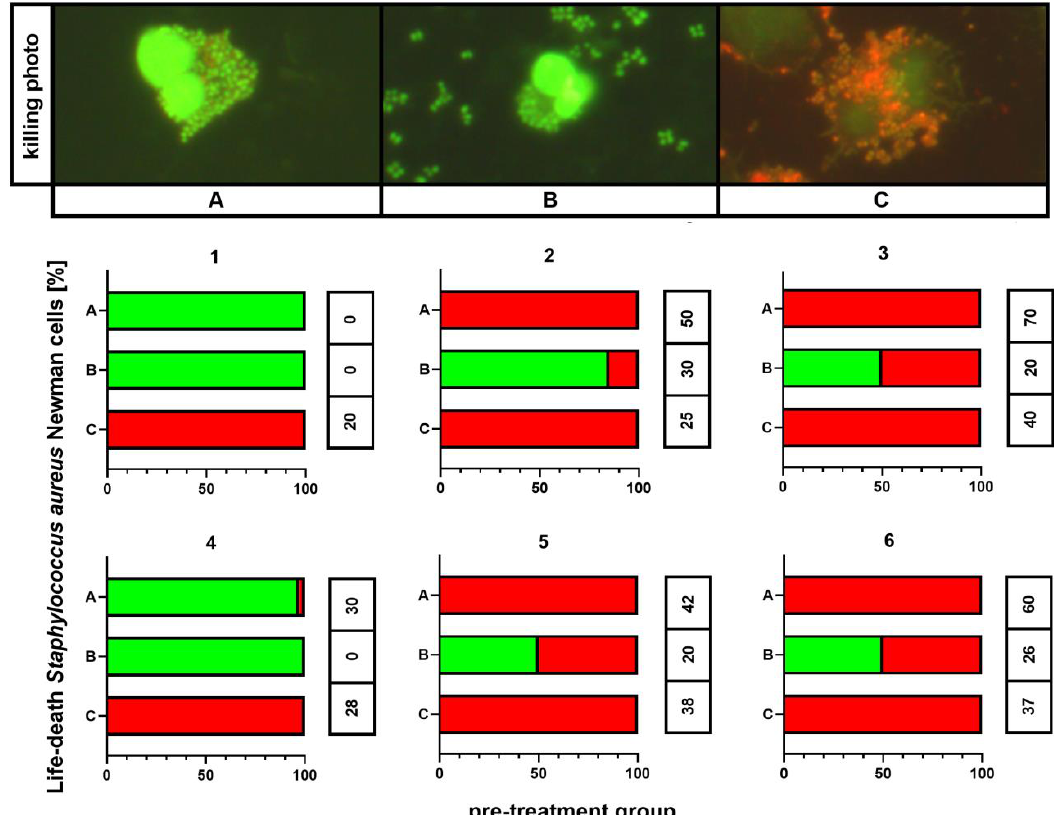
Figure 5. Killing activity assessment of S. aureus Newman cells. A—Mueller-Hinton agar non-supplemented (MHA, control), B—MHA supplemented with 1% ( v / v ) Tween 80, and C—MHA supplemented with 1% ( v / v ) Tween 80 and trans -anethole at subinhibitory concentration (MIC 50 ). The number above each plot represents the volunteer number. The values in the table represent the killing index. Photographic evidence of intracellular killed and living bacteria is presented in the pictures above the graphs (magnification: 400x).